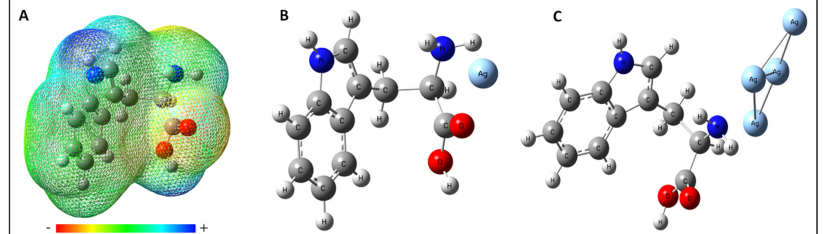
Figure 4. ( A ) Molecular electrostatic potential mapped on the isodensity surface for L-tryptophan calculated at the B3LYP/6-311++G (d,p) level of theory. Optimized structure for ( B ) Tryptophan with one silver-atom and ( C ) Tryptophan with a cluster of silver-atoms.